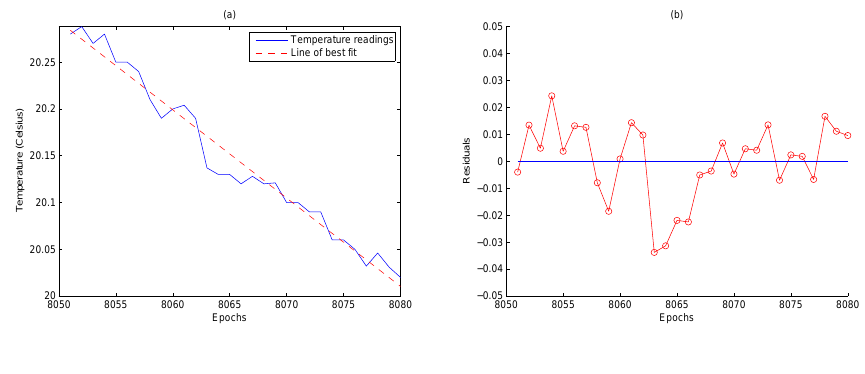
Figure 4. Temperature sensor readings and the corresponding residuals (Data obtained from Nelly Bay in the GBR